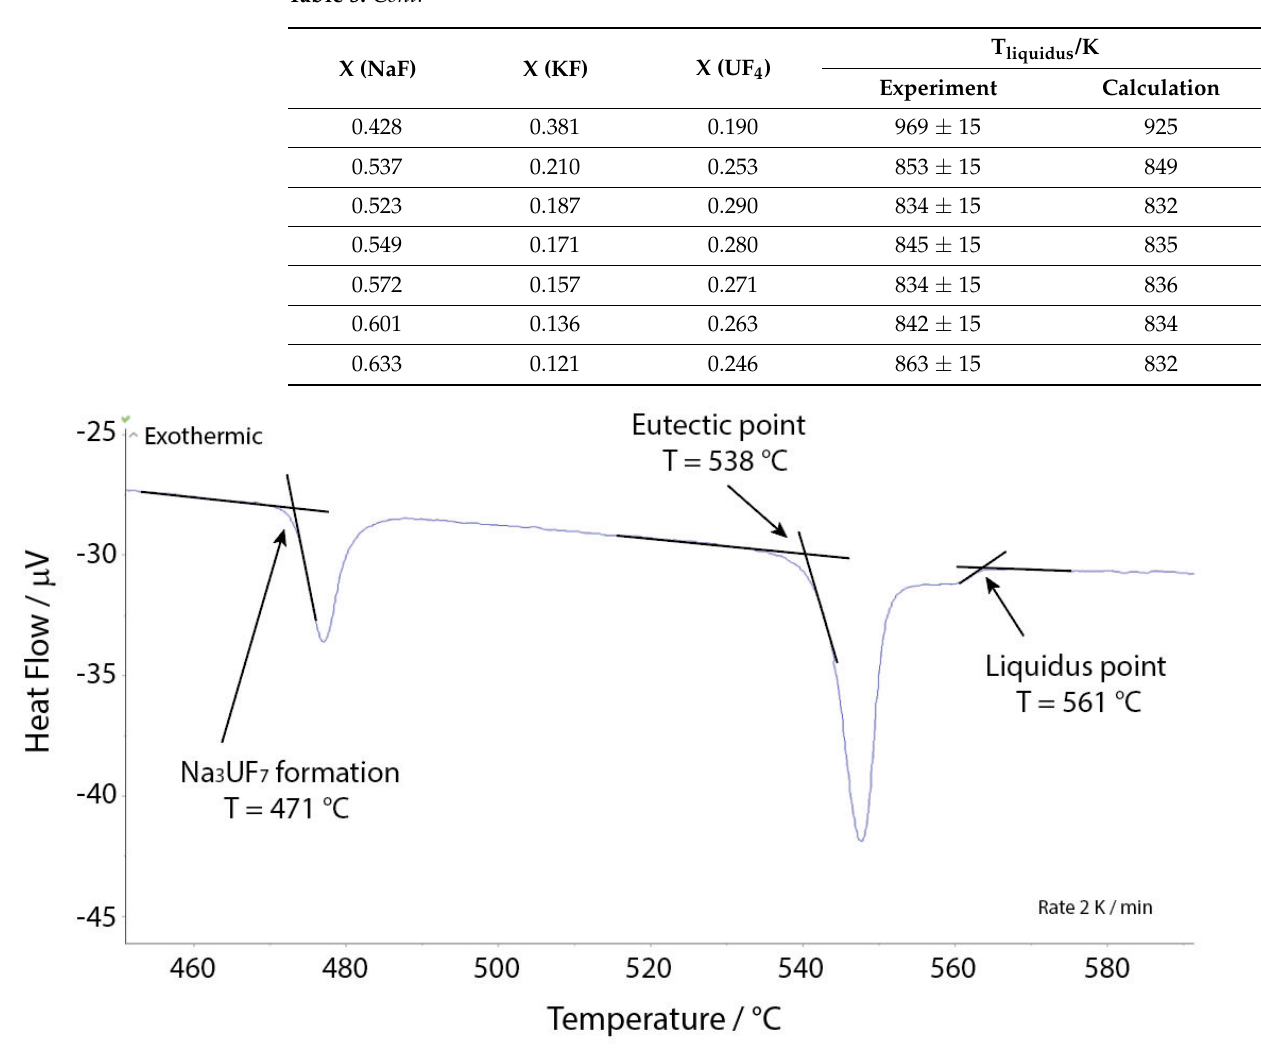
Figure 4. A DSC analysis of the phase equilibria determination of the selected NaF-KF-UF 4 (52.3-18.7-29.0 mol%)